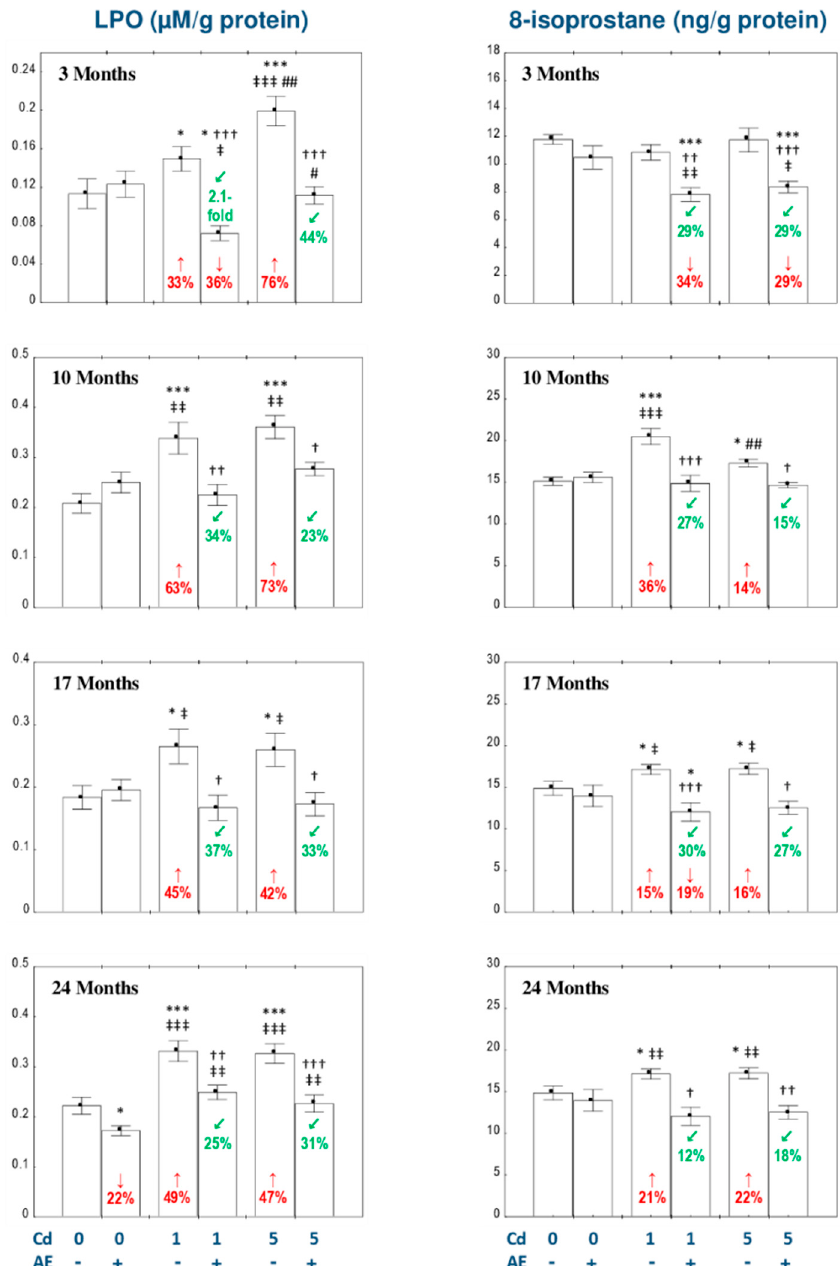
Figure 1. The influence of the extract from Aronia melanocarpa L. berries (AE) on the concentrations of lipid peroxides (LPO) and 8-isoprostane in the liver of female rats exposed to cadmium (Cd). The females were given Cd in the diet at the concentration of 0, 1, and 5 mg Cd/kg and/or 0.1% aqueous AE (+) or not (-). Data are represented as mean ± SE for 8 animals, except for 7 females in the AE, Cd 1 , and Cd 5 groups after 24 months. Statistically significant differences (ANOVA, Duncan’s multiple range post hoc test): * p < 0.05, *** p < 0.001 vs. control group; † p < 0.05, †† p < 0.01, ††† p < 0.001 vs. appropriate group treated with Cd alone; ‡ p < 0.05, ‡‡ p < 0.01, ‡‡‡ p < 0.001 vs. group administered with AE alone; # p < 0.05, ## p < 0.01 vs. appropriate group receiving the 1 mg Cd/kg diet (alone or with AE). Numerical values in bars or above the bars disclose the percentage changes or factors of changes in comparison to the control group ( ↑ , increase; ↓ , decrease) or the appropriate group given Cd alone ( ↙ , decrease).